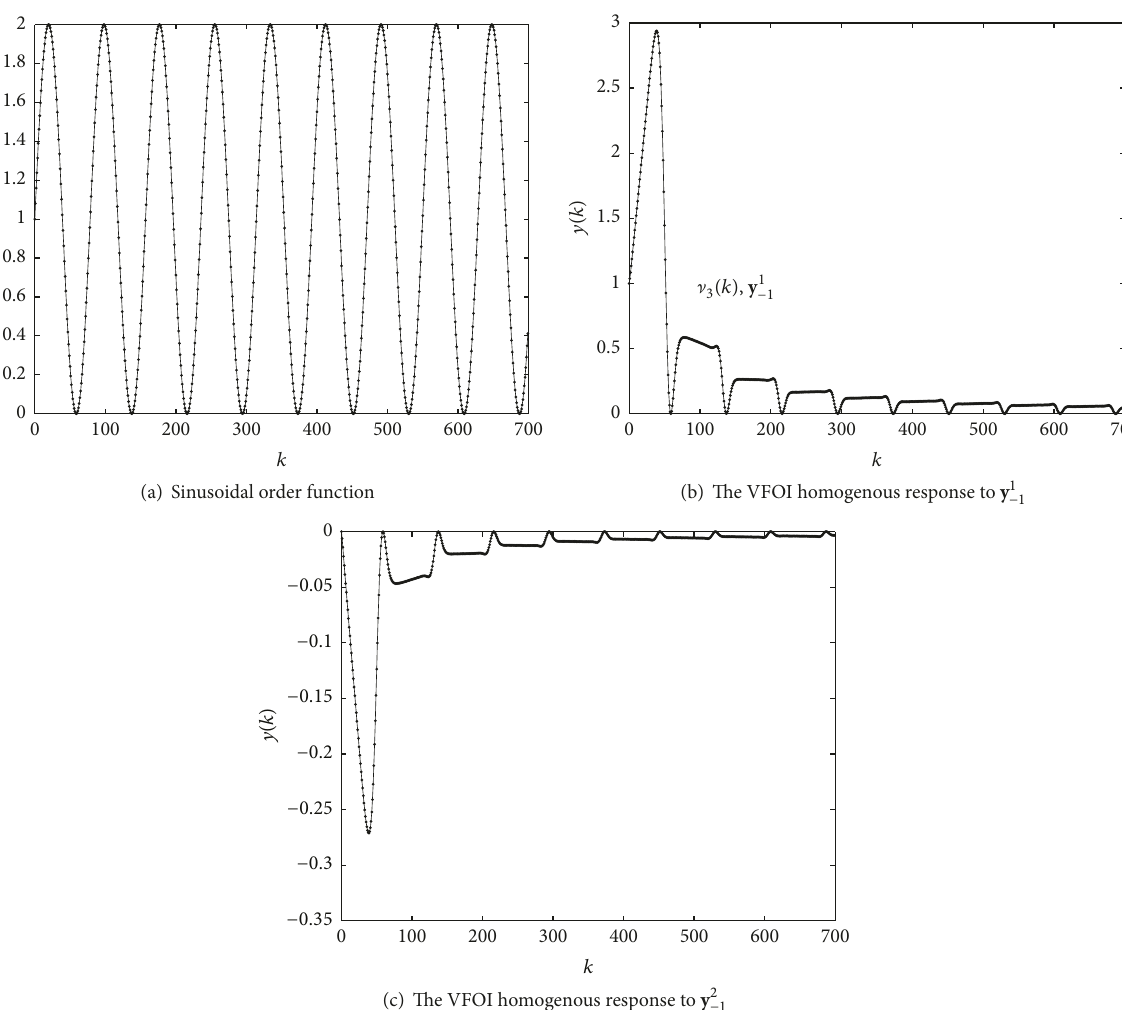
Figure 9: Plots of sinusoidal order function ] 3 (𝑘) = 1+ sin (𝜋𝑘/40) and the VFOI homogenous response to y 1 −1 and y 2 −1 represented by formula (34) with 𝑏 0 = 0.001, 𝑘 0 = 0